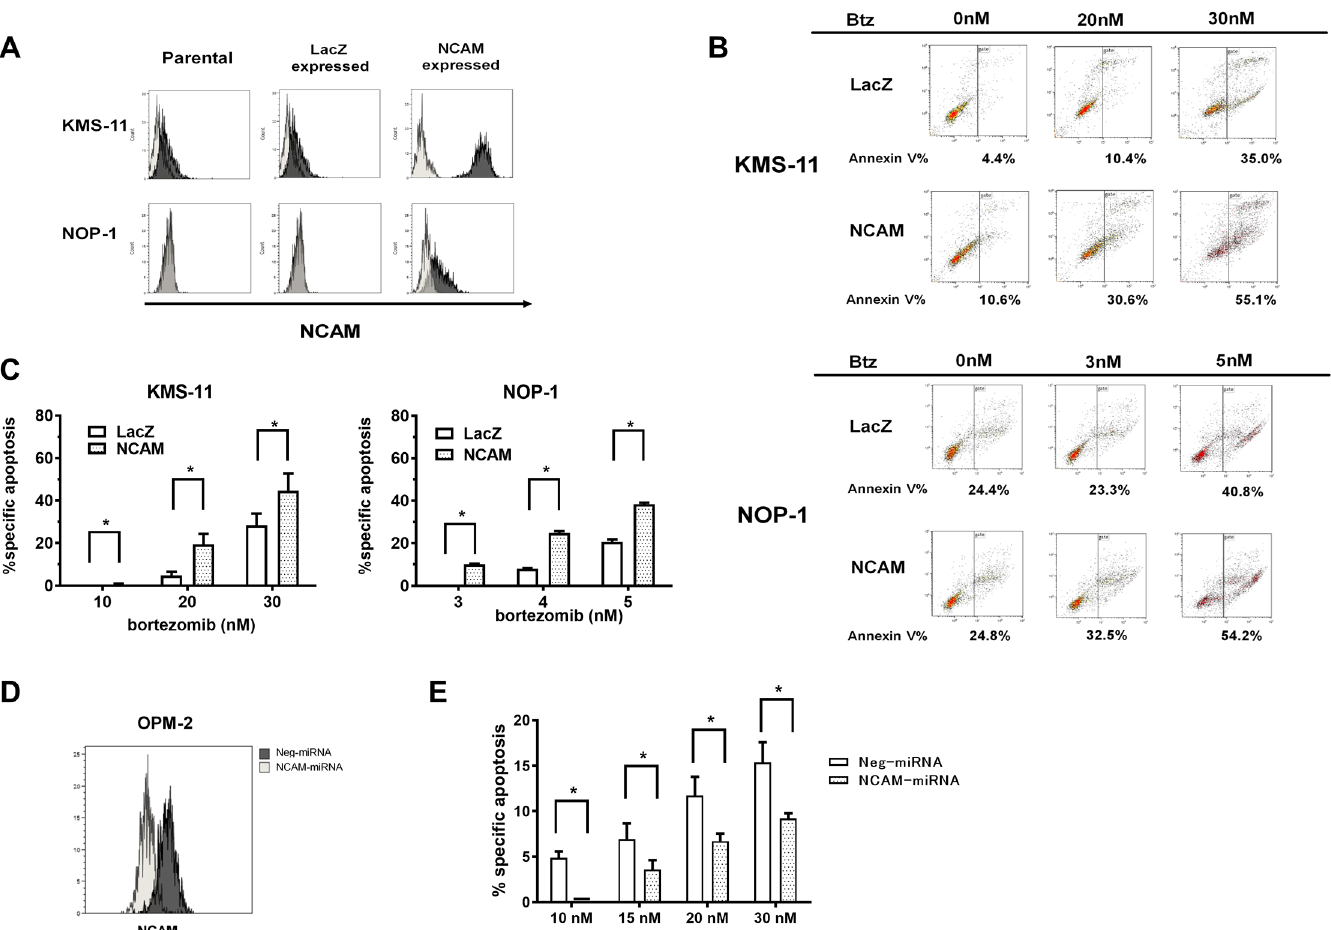
Fig 3. Comparison of rates of bortezomib (Btz)-induced apoptosis between cells with enhanced expression of neural cell adhesion molecule (NCAM) and LacZ- expressing cells. (A) Establishment of NCAM- or LacZ-expressing cells using two multiple myeloma (MM) cell lines, KMS-11 and NOP-1. Black area, CD56-PE; gray area, isotype. (B) Viability of NCAM- or LacZ-expressing cell lines after exposure to different concentrations of Btz for 16 h. (C) Evaluation of the percentage of NCAM- or LacZ-expressing cells undergoing specific apoptosis after exposure to Btz. (D) Establishment of NCAM knock-down cells using the OPM-2 cell lineage. Black area, cells transfected of negative (non-specific) miRNA cells; gray area, cells transfected to express NCAM-specific miRNA. (E) Evaluation of the proportion of NCAM knock-down cells undergoing apoptosis compared to that among control (miRNA-negative) cells after exposure to the indicated dose of Btz. (cid:3) indicates statistical significance ( p < 0.05), as calculated by student